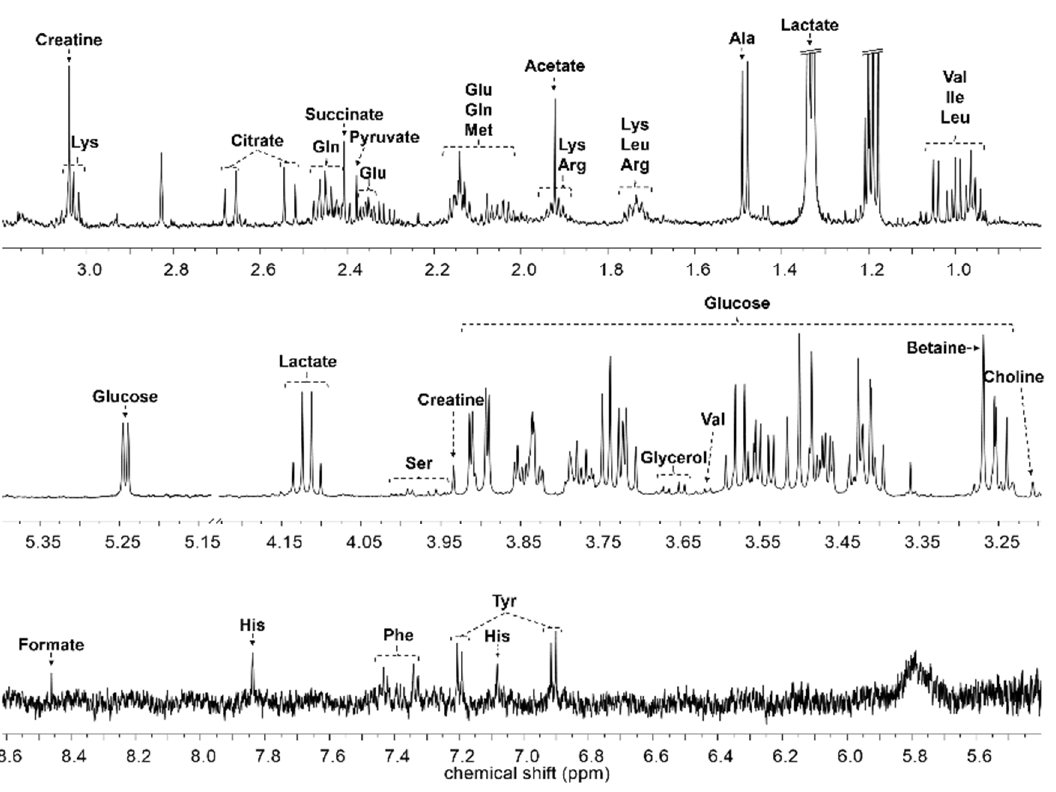
Figure 2. Representative 1 H nuclear magnetic resonance (NMR) spectrum of rat serum. The major metabolites are annotated on the spectrum.